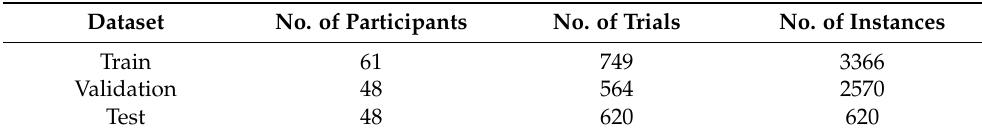
Table 2. Overview of the total number of participants, walking trials, and number of instances in the training, validation, and test set. A detailed overview with exactly for which trial and sensor location valid data were available can be found at https://github.com/rmndrs89/my-gait-events-tcn, accessed on 1 April 2022. Dataset No. of Participants No. of Trials No. of Instances Train 61 749 3366 Validation 48 564 2570 Test 48 620